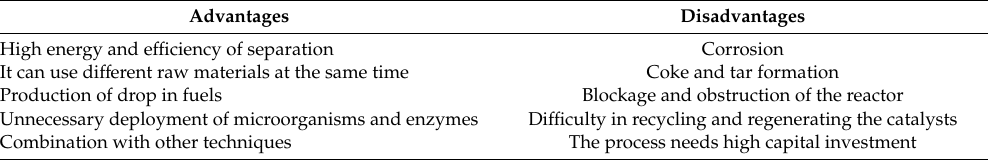
Table 1. Advantages and disadvantages of the hydrothermal